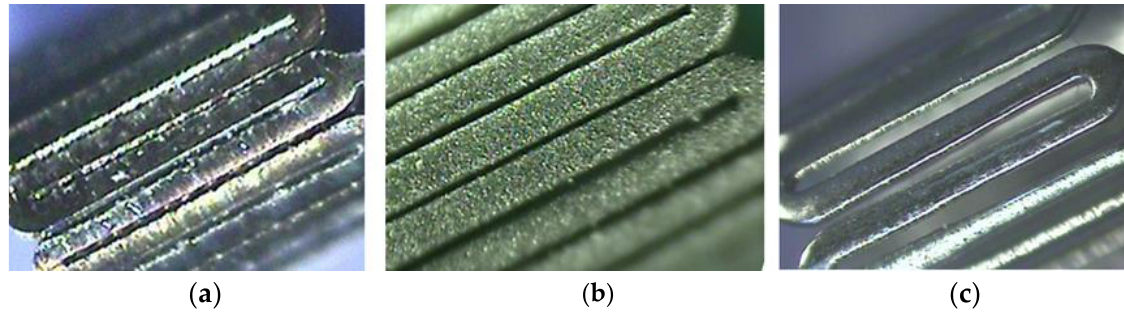
Figure 14. A stent after laser-cutting ( a ), sand-blasting ( b ), and electro-polishing ( c ).